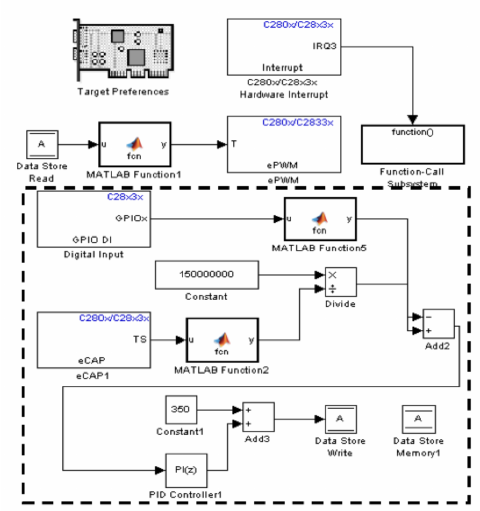
Figure 7. Model of the inverter